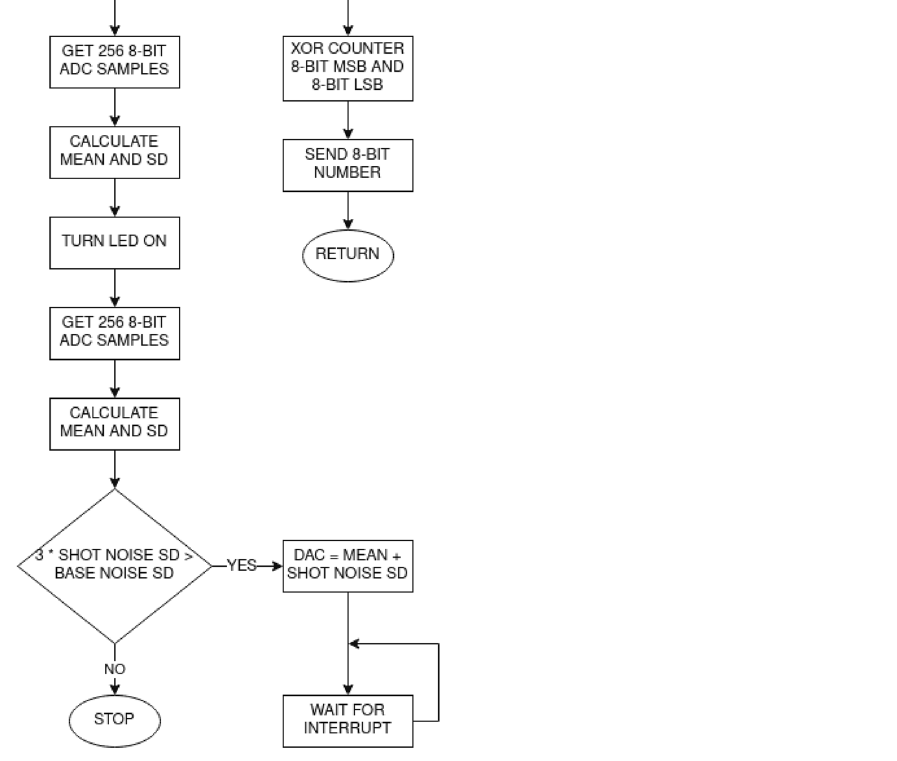
Figure 6. The scheme of the algorithm for automatic starting and calibration sequence and generating of random bit sequence implemented in